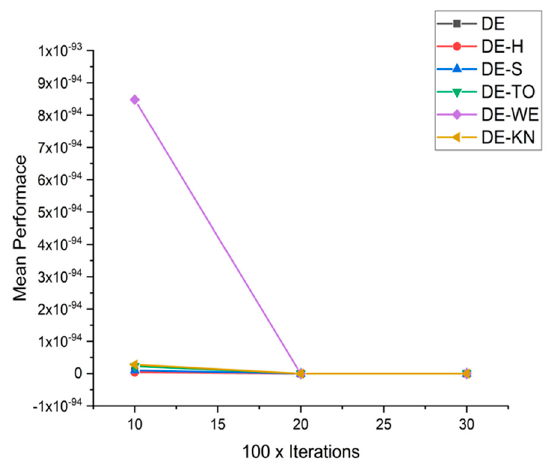
Figure 28. Convergence curve on fn6.